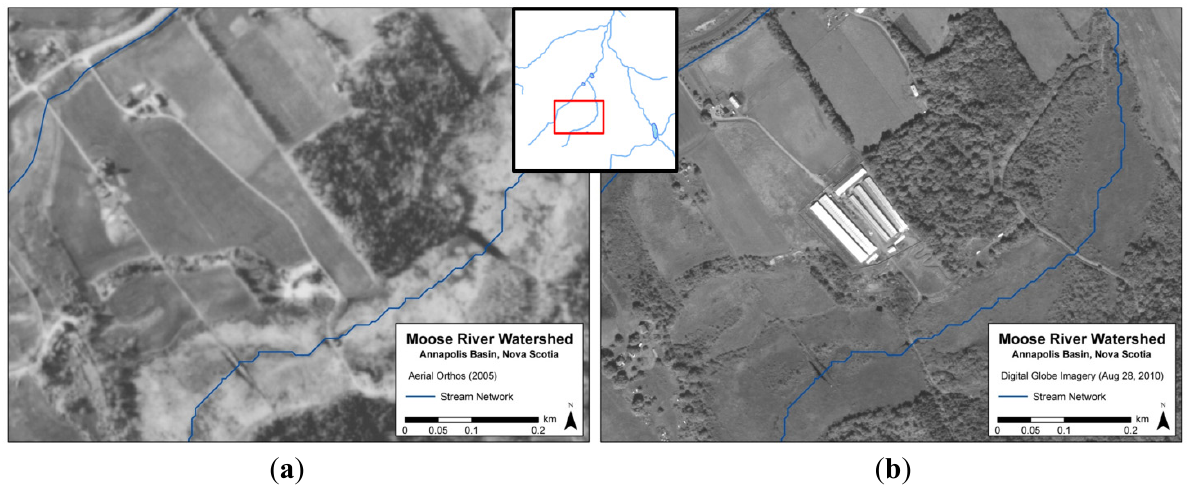
Figure 3. Aerial photograph (2005) ( a ) and Digital Globe World View 2 satellite imagery (2010); ( b) of mink farm site within Moose River